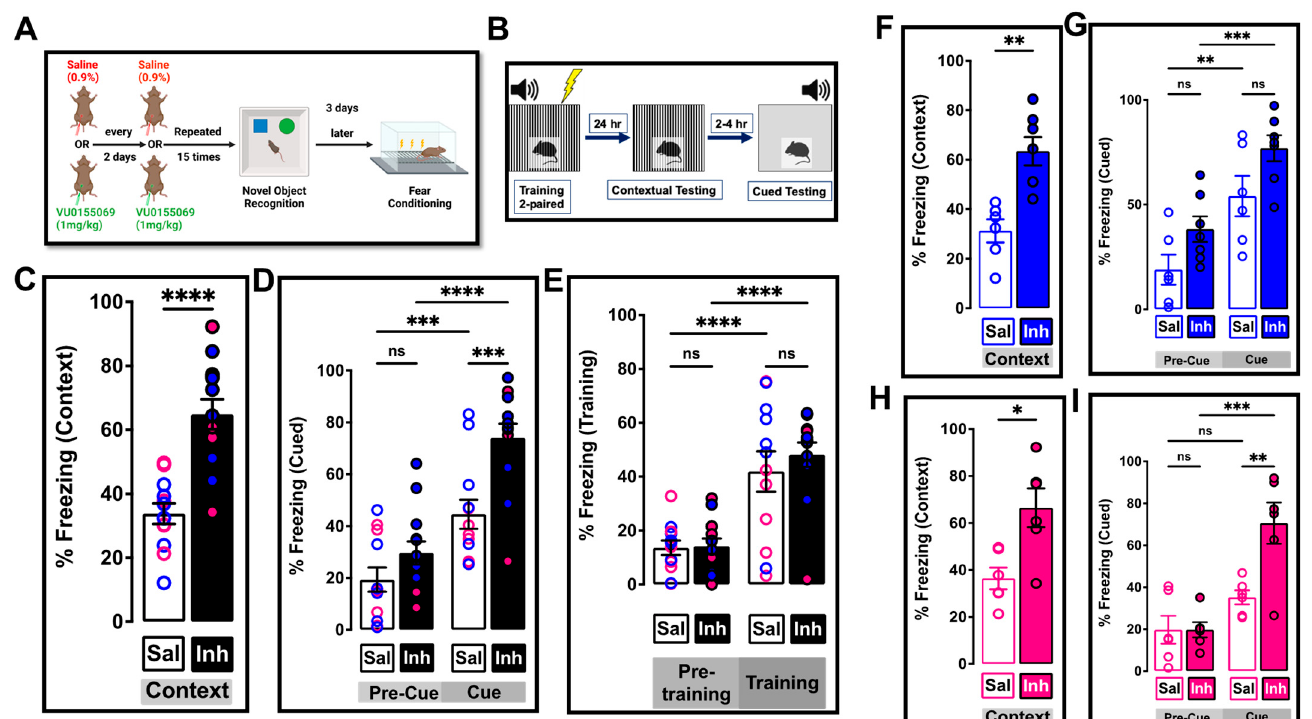
Figure 8. Chronic PLD1 injection prevents the cued and contextual memory deficit in 12-month-old 3xTg-AD mice. ( A ) The fear conditioned (FC) behavior was conducted in the same group of animals three days following the NOR test. ( B ) Schematic for FC training and testing is described in detail in the methods section. After a two-paired training regimen, animals were returned to their cages for 24 h prior to testing in the same context. After contextual testing, the animals were returned to their cages. After 2–4 h, the animals were introduced to a new chamber with different visual, tactile and olfactory characteristics. After a brief pre-cue period where the baseline level of freezing was assessed, the animals were given the sound cue. Once the behaviors were completed, the animals were returned to their cages. ( C ) During the contextual phase, the saline-treated animals show a greater level of activity (less % freezing) compared to the inhibitor-treated group, suggesting that more of the inhibitor-treated animals had retained the contextual memory associated with the shock (**** p < 0.0001). ( D ) In the freezing test, the pre-cue (before the sound is played) freezing response is not different (ns) between the two groups of 3xTg-AD mice. The post-cue response shows a significantly increased freezing response for saline and inhibitor compared to their respective pre-cue responses (*** p = 0.0005). Contrary to what we reported in 6-month-old mice, we report observing a significant difference in the cued response between the VU01-treated and saline-treated group, suggesting that the increased amyloidogenic insults show compromised cued memory at 12 months of age in this mouse model. ( E ) There were no differences in the two groups of animals in the extent of freezing before and during training. The increased freezing response for both the saline- and the inhibitor-treated groups was significant compared to their respective pre-shock response. Data were separated into ( F ) or ( G ) males and ( H ) or ( I ) females, where saline-treated animals are shown in clear bars while inhibitor-treated animals are shown in filled bars. In the contextual response, that mirrors the NOR response, both ( F ) male (** p = 0.0012; n = 6–7 mice) and ( H ) female (* p = 0.0152; n = 6 mice) show improvement in their contextual memory compared to their saline-treated siblings. Interestingly, in the cued response, ( G ) the post-cue freezing in the saline-treated male (clear bars and clear circles) mice does not reach significance compared to pre-cue (Sal: 54.010 ± 9.649 vs. Inh: 76.900 ± 6.201; p = 0.0571; n = 6–7 mice), but ( I ) the difference in response between the female treatment group does show significance (** p = 0.0036; n = 6 mice). When examining the individual responses, the variability in the male response, post-cue, is more compared to the females. More importantly, the inhibitor-treated animals (filled bars and filled circles) in both male (*** p = 0.0003) and female mice (**** p = 0.0001) are significantly different compared to pre-cue and show no difference between the sexes, suggesting that the treatment with the PLD1 inhibitor has similar effects between the sexes and promotes protection against the A β and tau-driven insults on cued (amygdala-dependent) memory expression. Saline-treated animals are shown in clear bars while inhibitor-